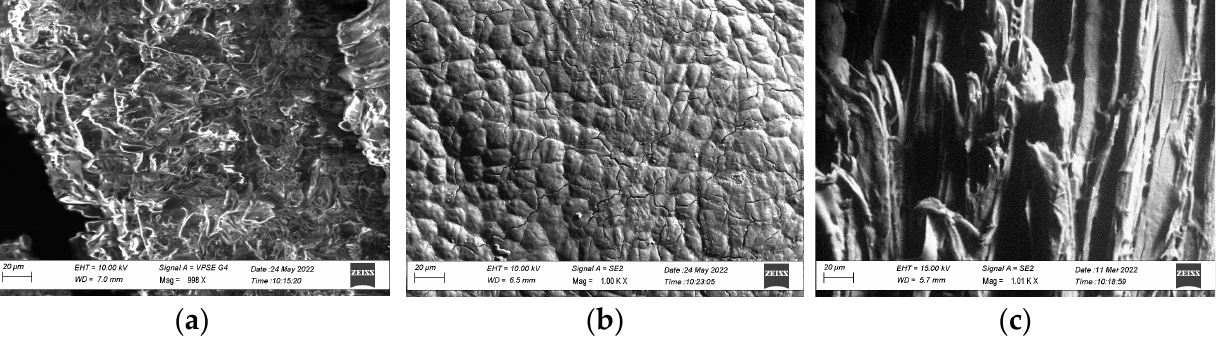
Figure 3. Morphology of the aggregates before mixing: ( a ) coffee grounds, ( b ) fava bean residues, ( c ) sawdust powder. Mean magnification level 1000 kx.